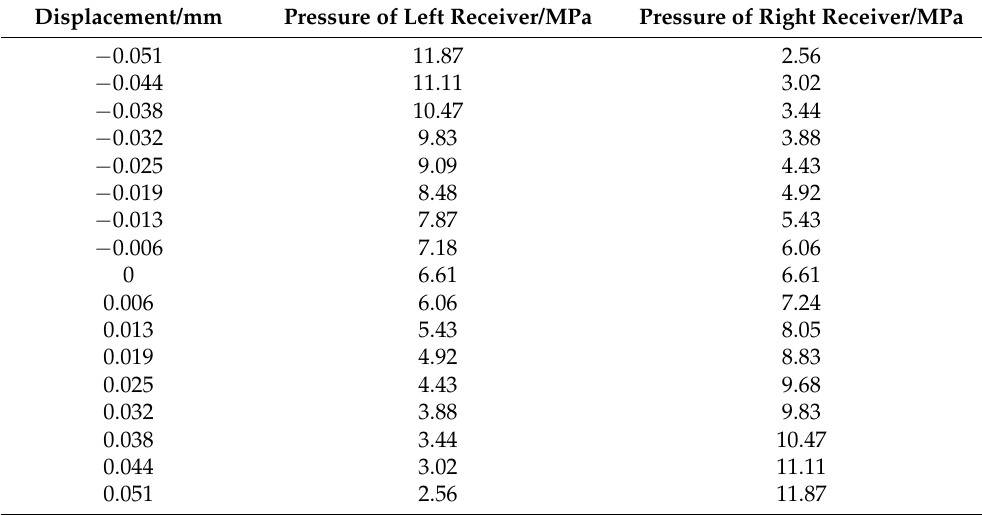
Table A1. Calculations of receiver pressures.